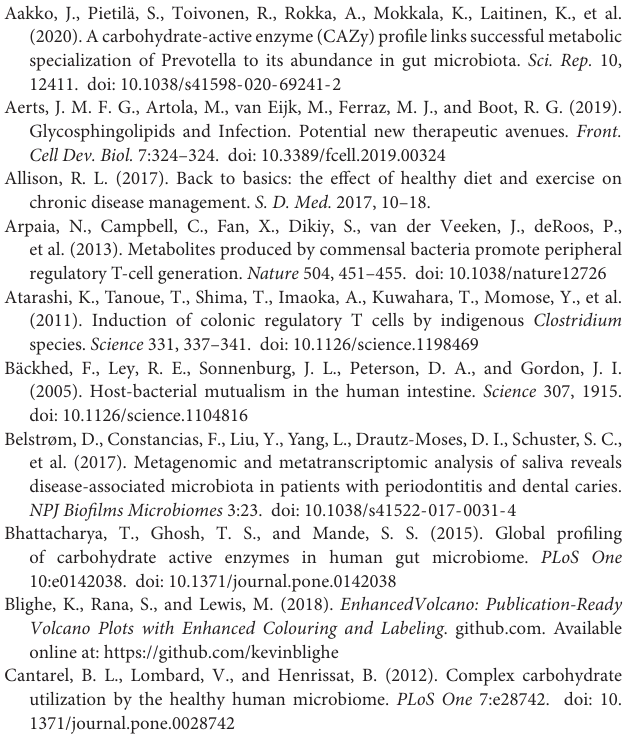
Supplementary Figure 1 | Correlation between total gene copies of CAZymes per genome and genome size of the 310 type strain recovered from 935 saliva and stool samples of both healthy and diseased subjects. Supplementary Figure 2 | Phylum and genus-specific CAZyme family signatures based on Z score standardization. A heatmap of CAZyme family totals annotated from 310 bacterial genomes in 935 metagenomes obtained from the oral (saliva) and gut (fecal) samples of healthy subjects, as well as patients suffering from type 1 diabetes, colorectal cancer, and rheumatoid arthritis. A total of 27 distinct Carbohydrate-Binding Module (CBM), 13 Carbohydrate Esterase (CE), and 2 CAZymes performing Auxiliary Activity functions (AA) from nine phyla and 86 genera are represented. Each genus displays specific CAZyme enrichments